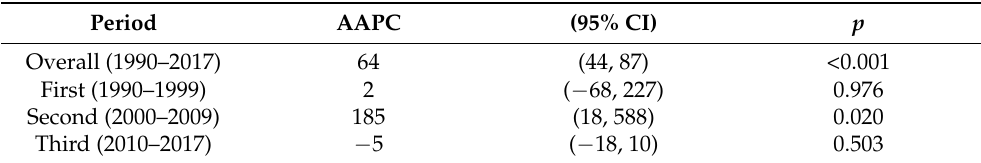
Table 1. Annual Percent Change of DALYs rates. Abbreviations: DALYs, Disability-adjusted life years; APC, the annual percentage of change.